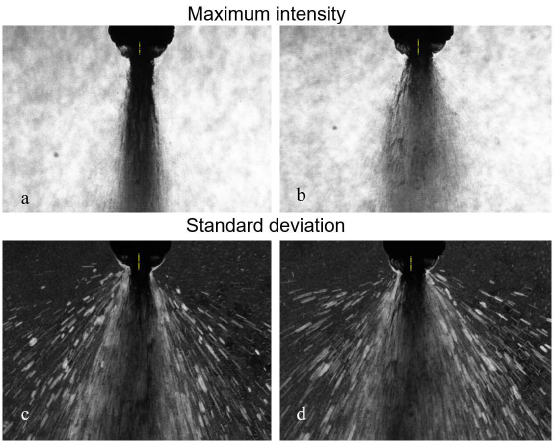
Figure 13. Breakup length measurement with the 280 µm sheet with a water and airflow rate of 100 kg/h and 20 kg/h, respectively, ( a , c ) for the converging atomizer and ( b , d ) for the converging–diverging (CD) atomizer.